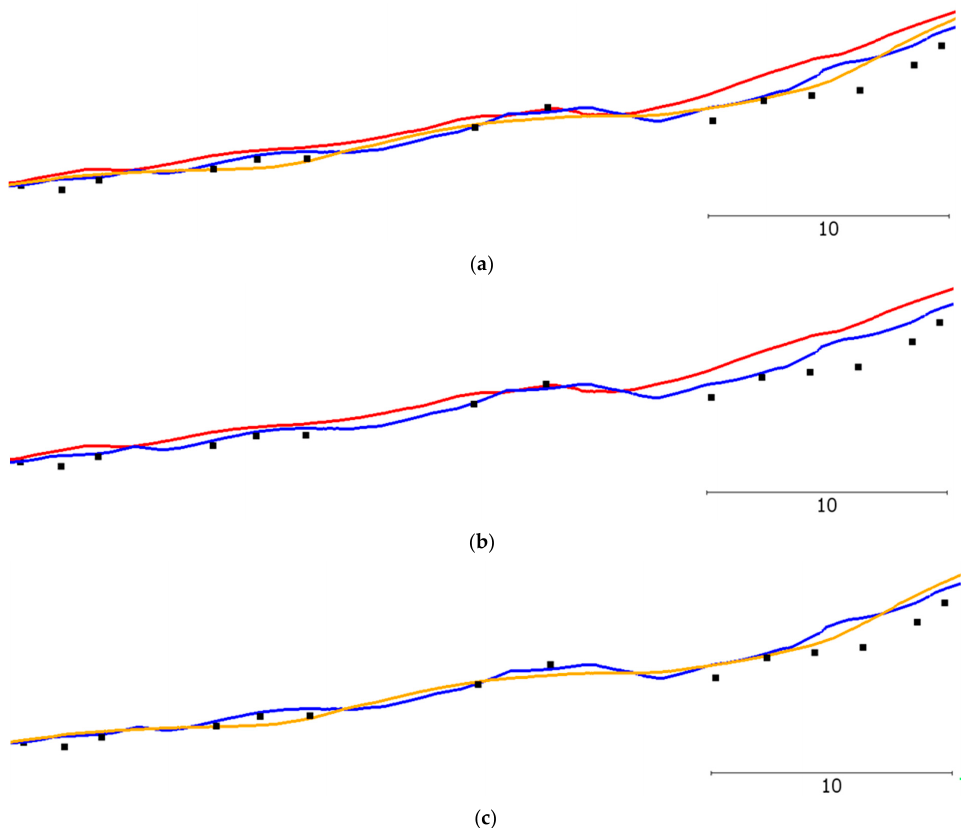
Figure 15. Comparative longitudinal vertical sections executed on the 3D models, the black squares represent the points used for validation: ( a ) comparison between the 3D model FCR (in blue), the 3D model OK (in orange) and the 3D model IDW (in red); ( b ) comparison between the 3D model FCR (in blue) and the 3D model IDW (in red); ( c ) comparison between the 3D model FCR (in blue) and the 3D model OK (in orange).